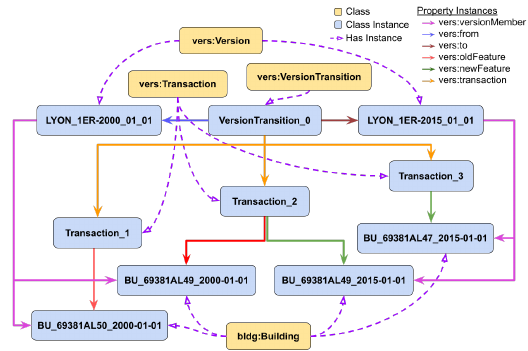
Figure 5. Diagram of an RDF Graph of a Historical Succession Transition of Between 2 City Model Versions (above) with several Buildings